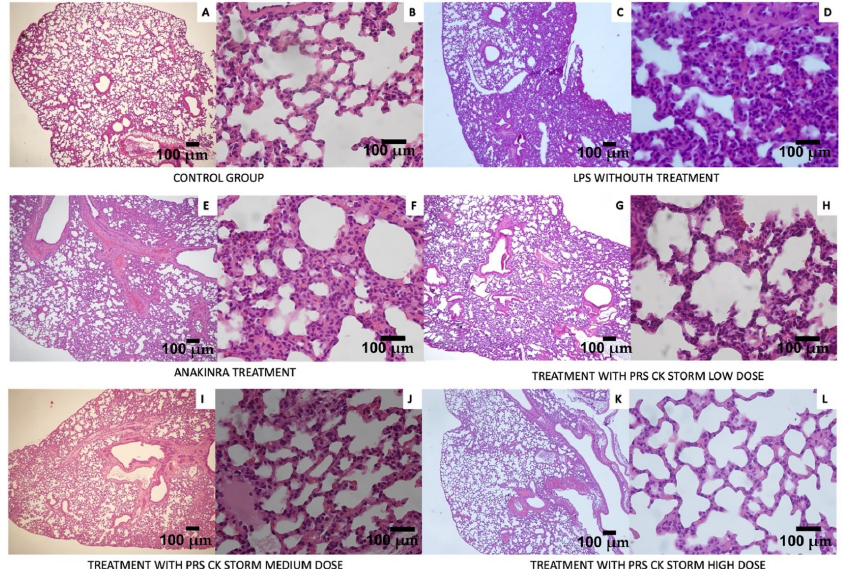
Figure 10. Lung anatomo-pathological study in the different groups of mice in the experiment (all figures shows representative microscopic images of the lung). In the group treated with the highest dose of our conditioned medium, the appearance of the lung is very similar to that of the untreated control group. ( A , B ) shows that no pathological findings were observed in the lung samples ana- lyzed in the control group. ( C , D ) shows an irregular thickness of the interstitium in more than 50% of the section, and inflammatory cells can be observed as part of the interstitial thickness in the lung